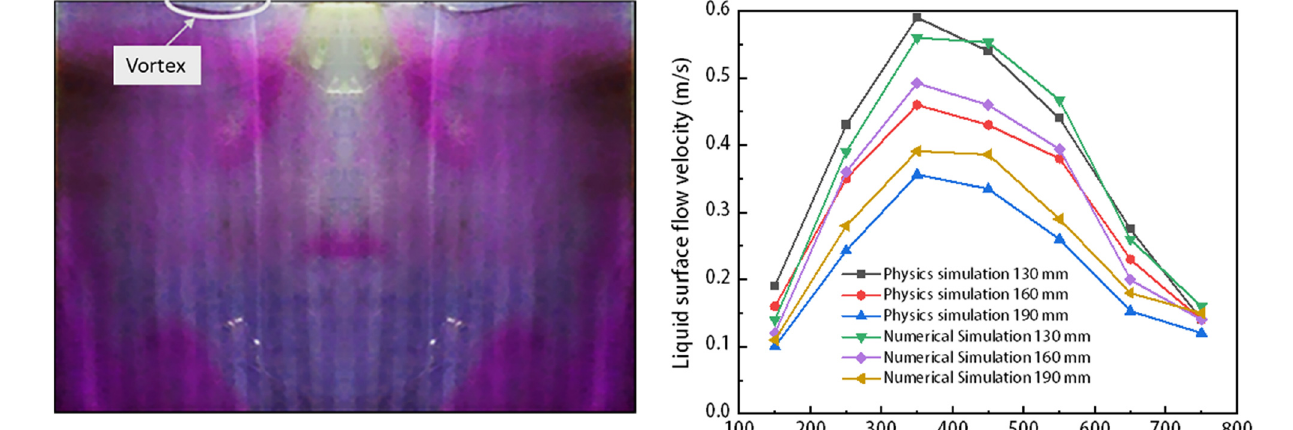
Figure 7: Typical liquid level fl uctuation.